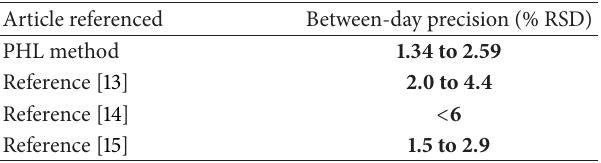
Table 3: Comparison of between-day precision values for the Washington State Department of Health (PHL) method and three LC/MS/MS methods referenced in this